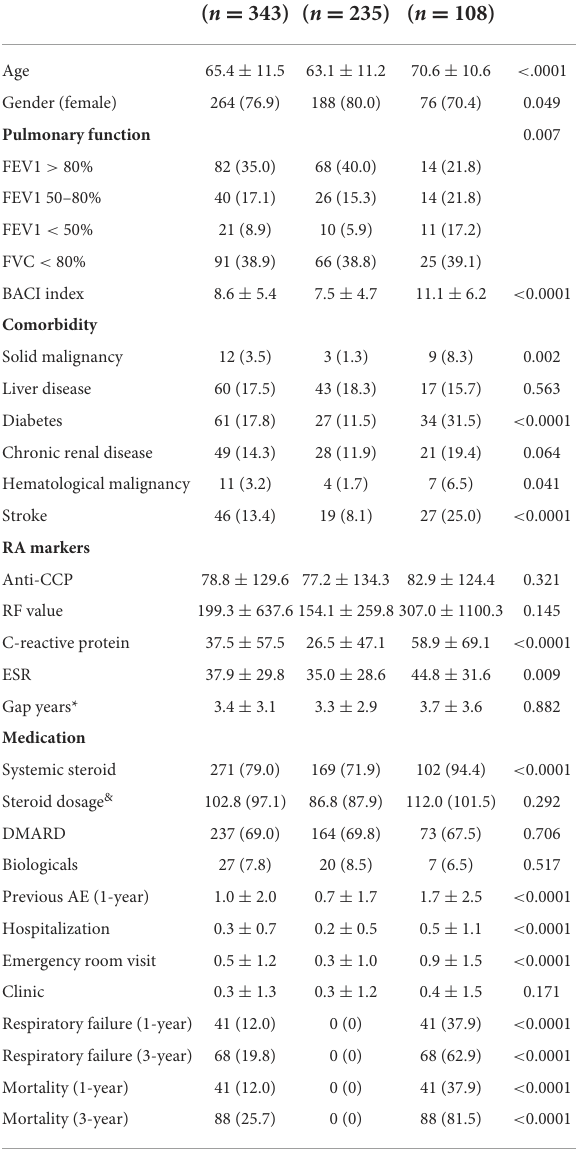
TABLE 1 Characteristics and outcomes of BROS with or without severe exacerbation. Total General